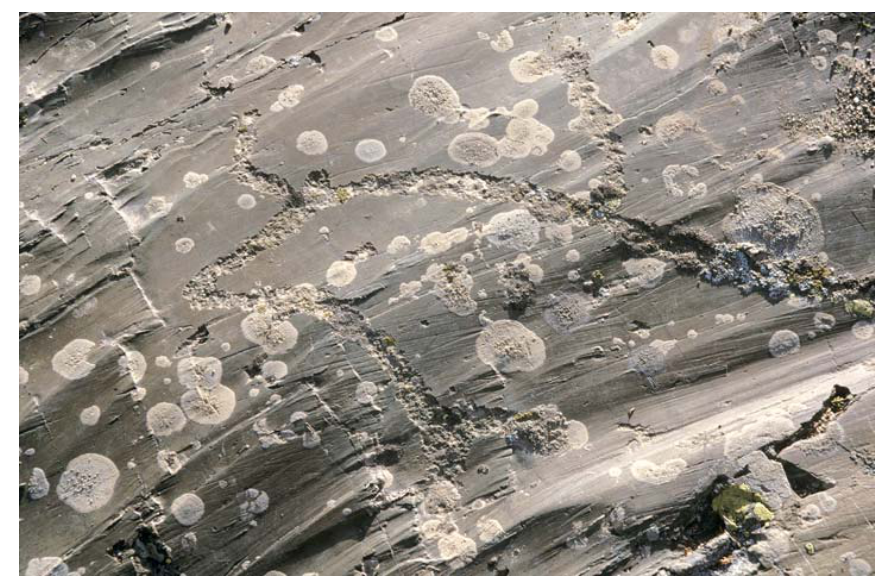
Figure 4. Unfinished aurochs on scraped and polished outcrop. Pre-Bronze Age (Paleolithic period). Aral Tolgoi.